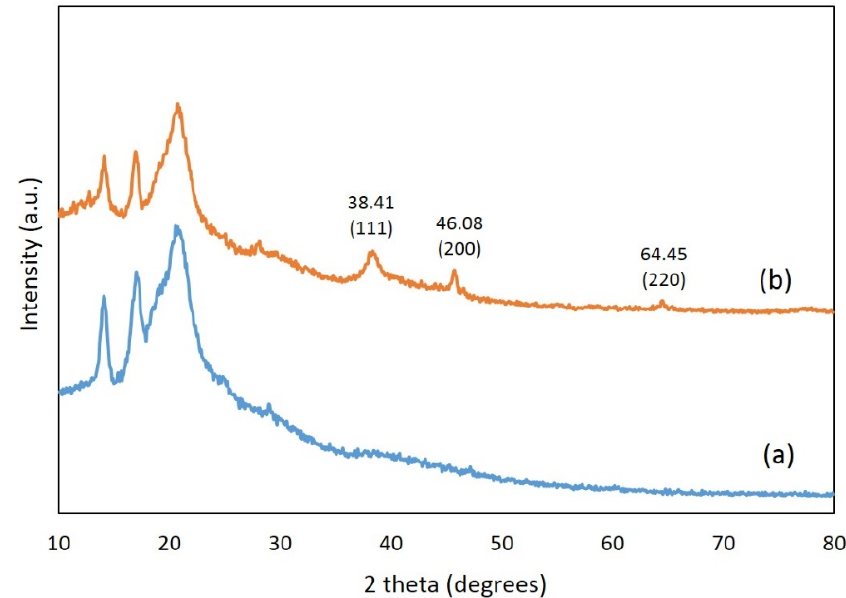
Figure 5. The Scanning Electron Microscope (SEM ‐ EDX), images of SS ‐ AgNP functionalized silk fabrics ( a ) untreated at 1000×; ( b ) treated at 1000×; ( c , d ) EDX pattern and AgNP distribution of treated fabrics.